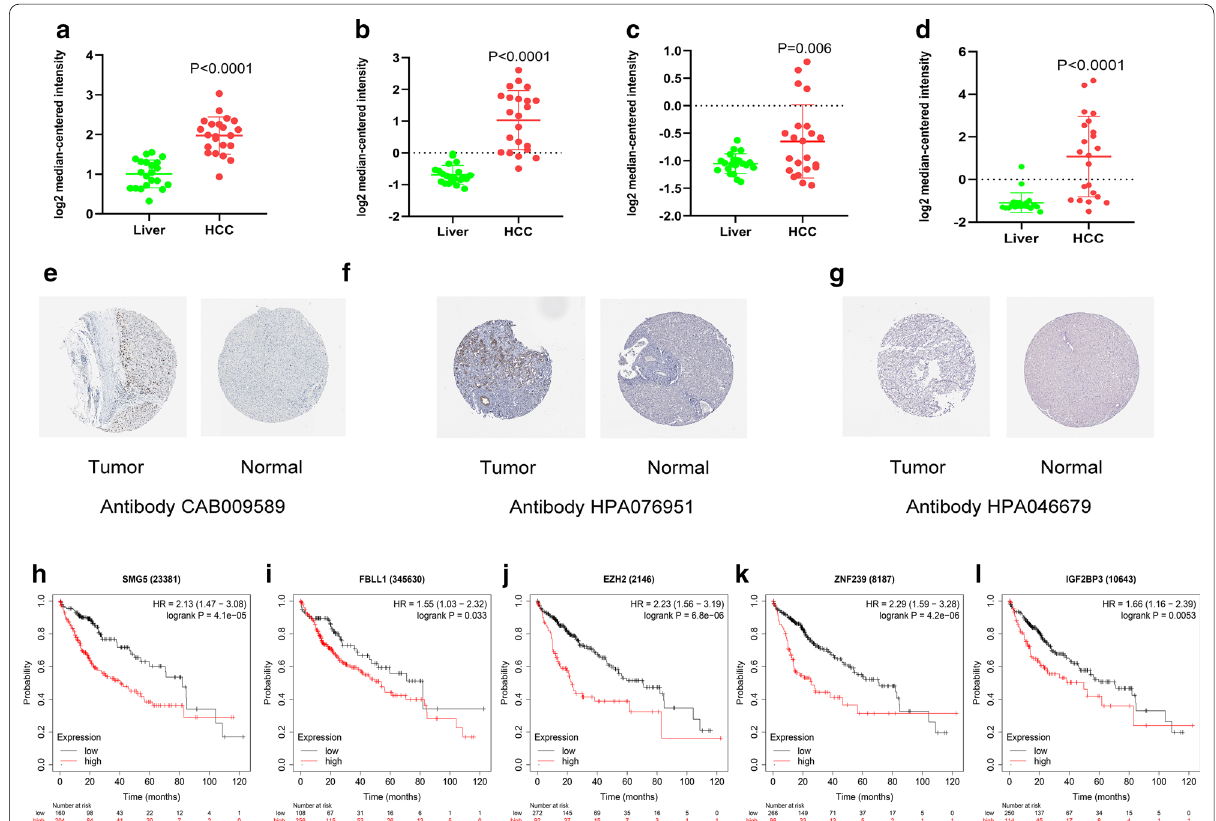
Fig. 9 The expression level of SMG5, EZH2, FBLL1, ZNF239, IGF2BP3 in the Oncomine database and The Human Protein Atlas. a Expression level of SMG5 in HCC and Liver. b Expression level of EZH2 in HCC and Liver. c Expression level of ZNF239 in HCC and Liver. d Expression level of IGF2BP3 in HCC and Liver. e Immunohistochemistry results of EZH2 in HCC (Staining: Medium; Intensity: Moderate; Quantity: 75–25%; Location: Nuclear) and in normal tissue (Staining: Not detected; Intensity: Negative; Quantity: None; Location: None). f Immunohistochemistry results of IGF2BP3 in